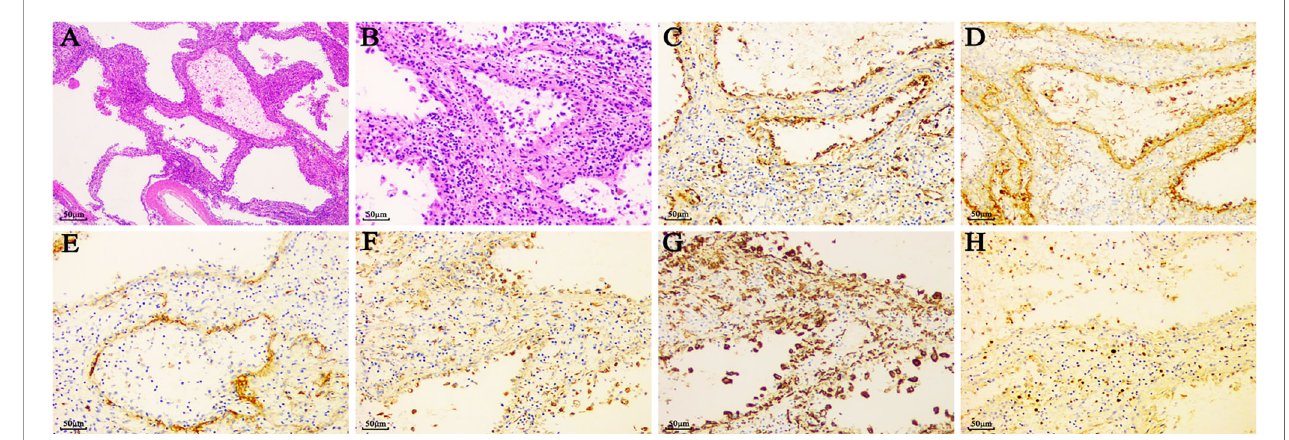
FIGURE 4 | The typical pathological features of LCA. (A) (×40) & (B) (×200). HE staining of LCA showed sinus like anastomosing channels with an irregular lumen, which was lined with tall, plump endothelial cells. Of the vascular markers, LCA reacted positively with (C) CD31, (D) factor VIII, and (E) CD34. Of the histiocytic markers, LCA typically expressed with (F) CD68 and (G) CD163. (H) A positivity rates of Ki67 was approximately 5%.